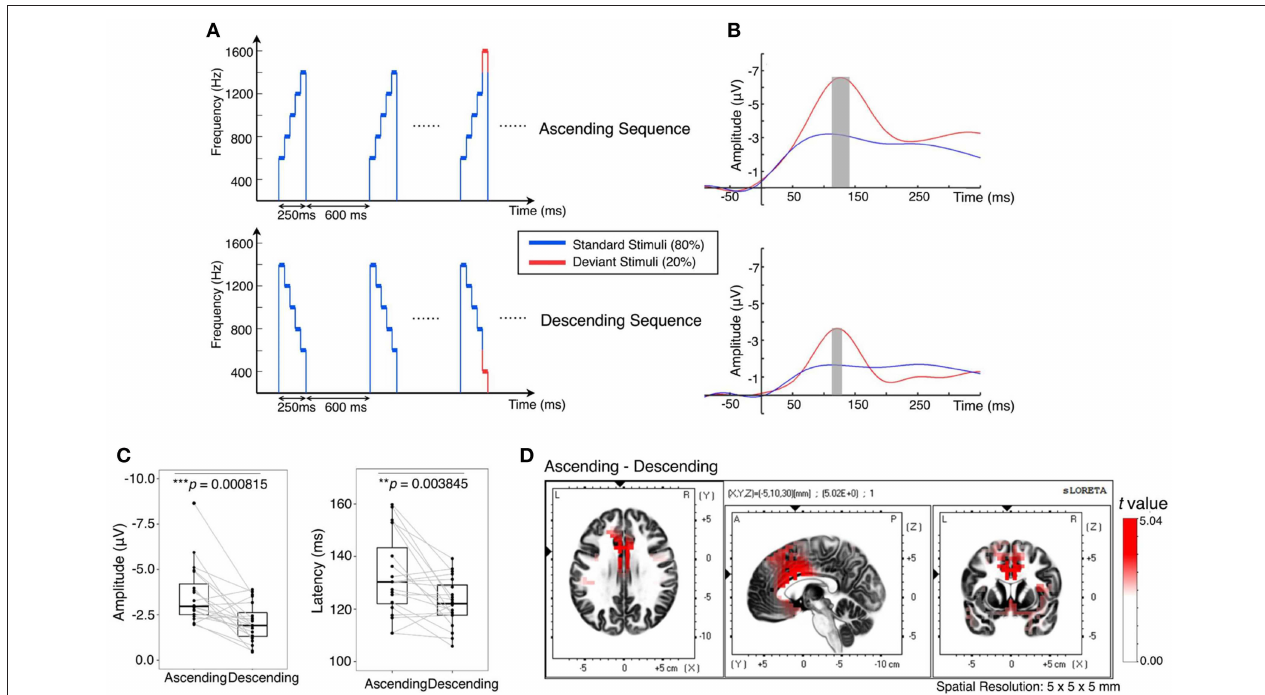
FIGURE 1 | Contextual effect on brain responses to unattended sound changes. (A) Twenty percent of the stimuli set in either context had a deviant tone (plotted in red): a 200 Hz additional pitch increment or decrement tone in substitution to the fifth tone of the standard stimuli. (B) Grand average MMN at electrodes having the largest difference between standard and deviant in the fronto-central region. Gray bars are peak intervals (peak latency ± SD , N = 20) for ascending context at 118–149 ms and descending context at 114–132 ms. (C) MMN amplitude was greater in the ascending context (–3.60 ± 1.65 µ V) than in the descending context (–2.08 ± 1.06 µ V), t (19) = –3.97, p = 0.0008. MMN latency was greater in the ascending context (132.84 ± 15.53 ms) than in the descending context (122.55 ± 9.15 ms),